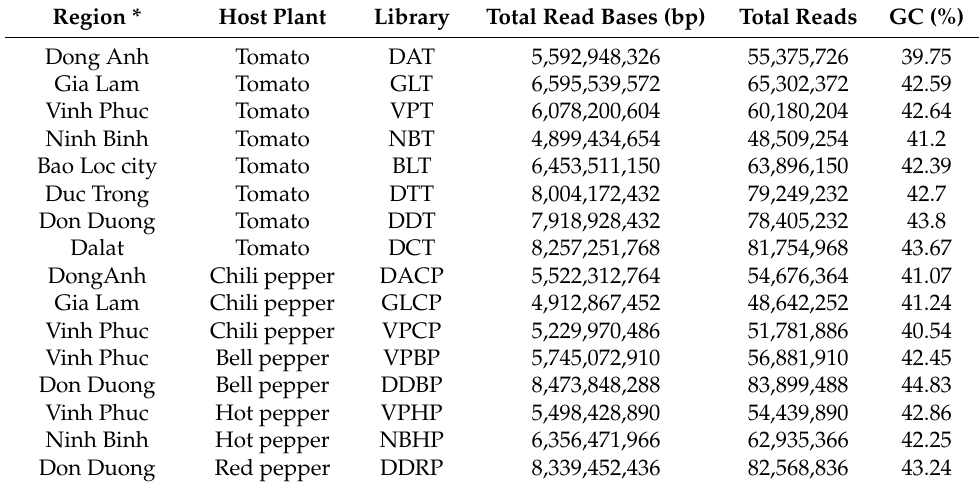
Table 2. Detailed Information for RNA-Seq Libraries and RNA-Seq